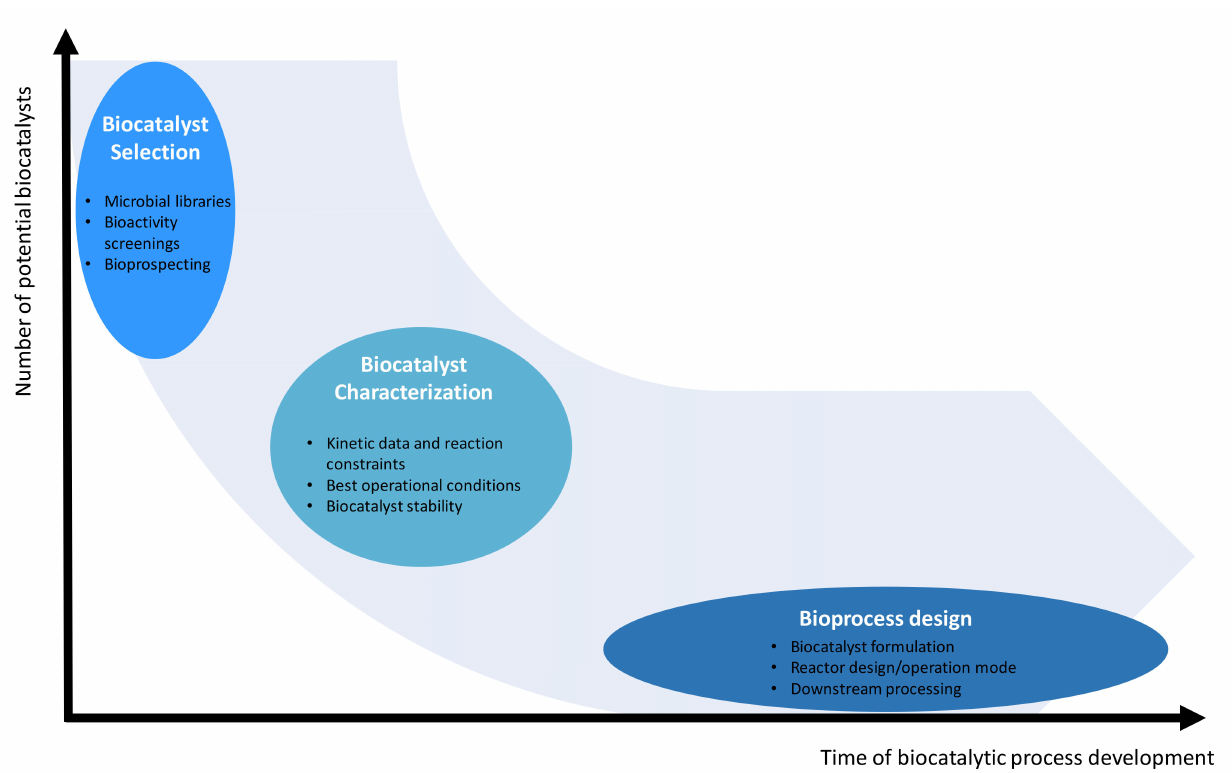
Figure 3. Conceptual visualization of the simultaneous number of biocatalysts to be tested during the different steps of the biocatalytic process development. At the early stages, a large number of putative candidates are tested, preferably by using high-throughput assays. After identification of the most active candidates, the effect of reaction conditions on kinetic data and biocatalyst stability are tested. The best candidate is then selected for the development of the production process, where biocatalyst formulation, reactor type and operation mode, and extraction and purification of product(s) are tested and